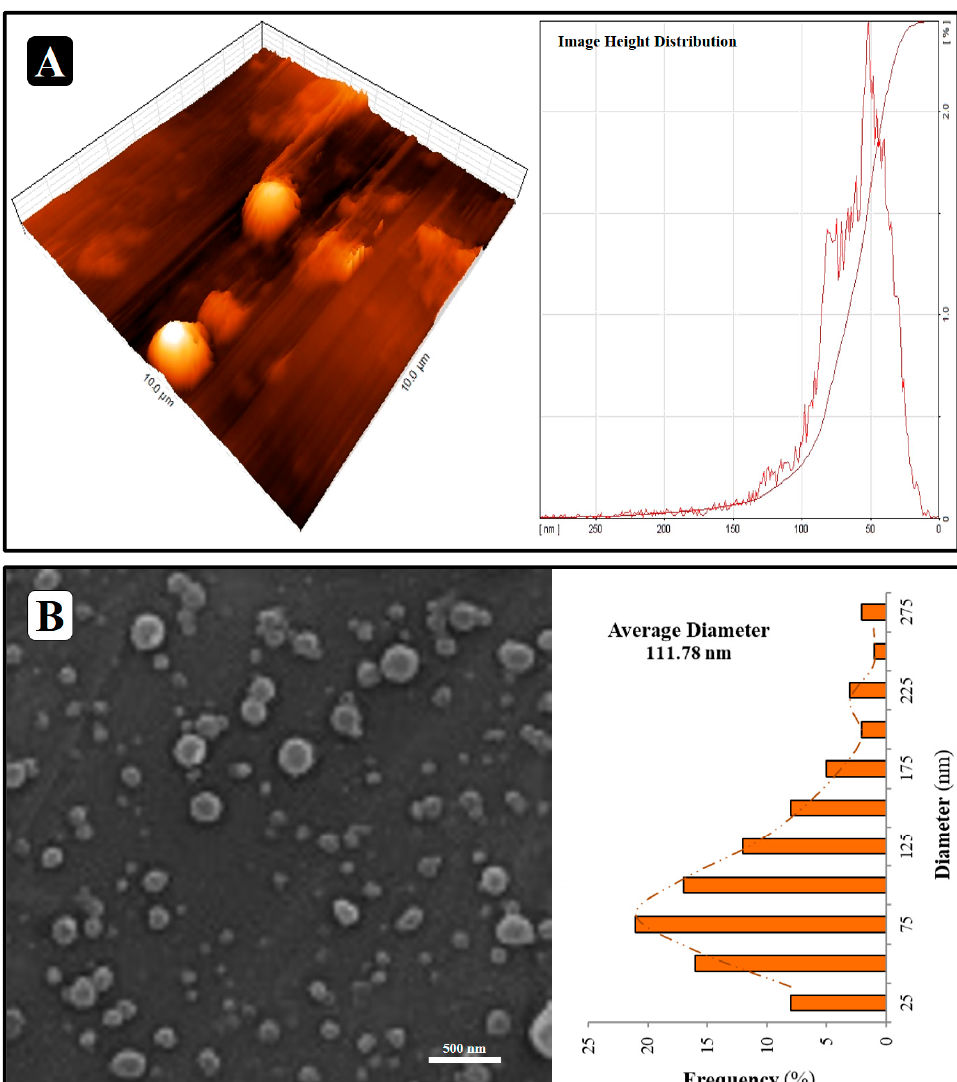
Figure 3. AFM ( A ) and SEM ( B ) micrographs of NL P /A EO